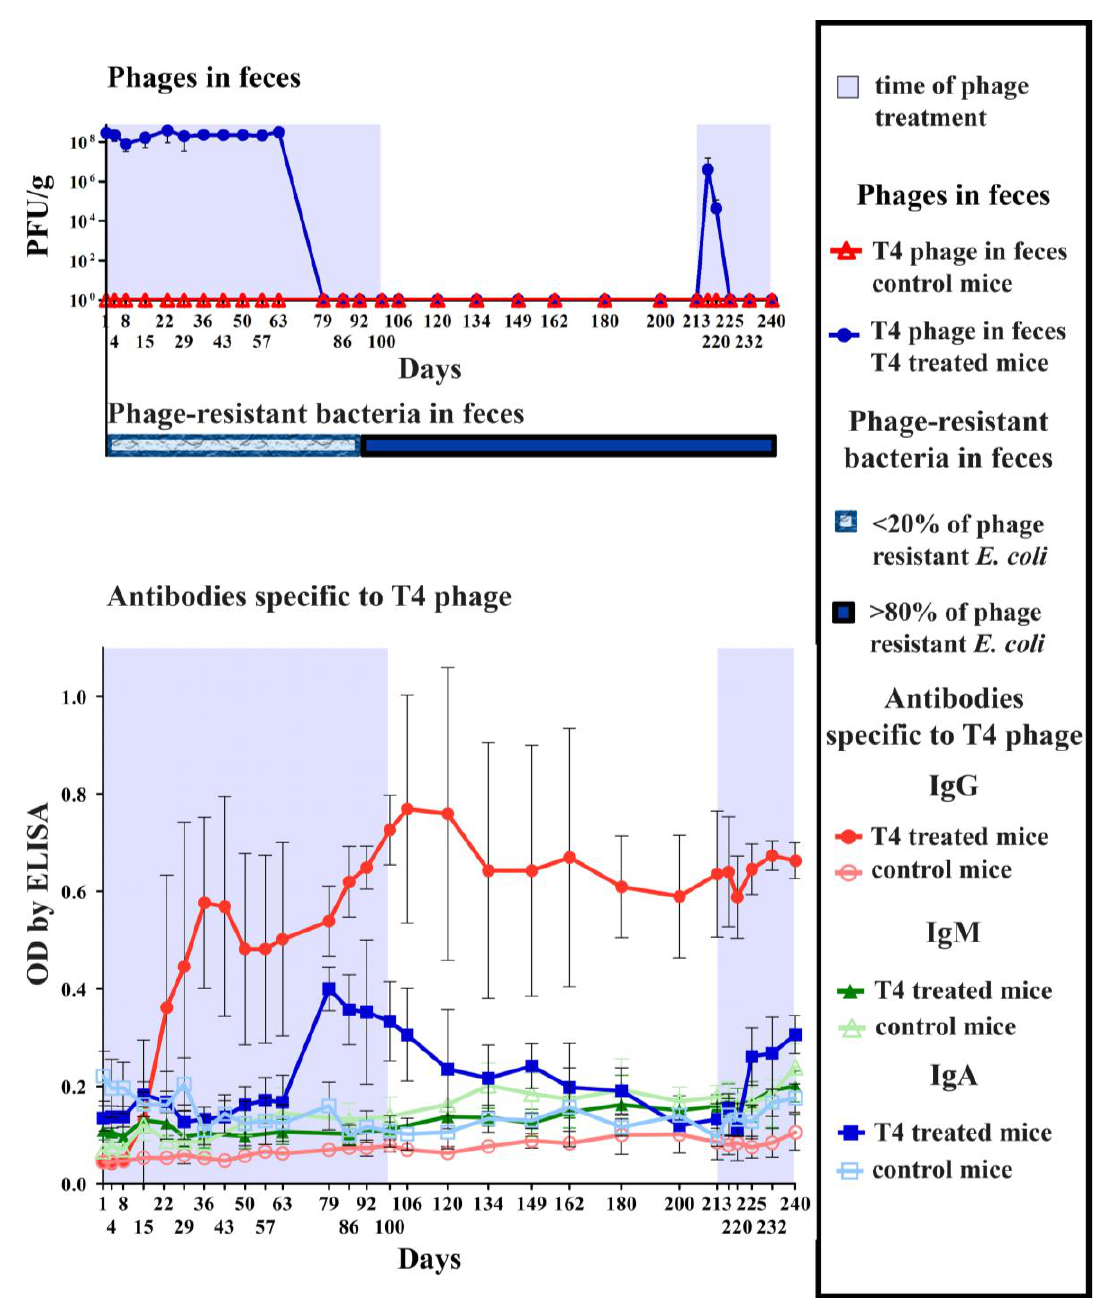
Figure 1. Bacteriophage T4 survival in the gut in correlation with increase of specific anti-phage antibodies and with emergence of phage-resistant E. coli . Mice ( N = 7) were fed with T4 phage in drinking water to preclude micro-injuries that can be caused with a stomach probe and which result in false observations of phages penetrating the blood. The treatment was conducted for 100 days (days of phage treatment were marked in the figure